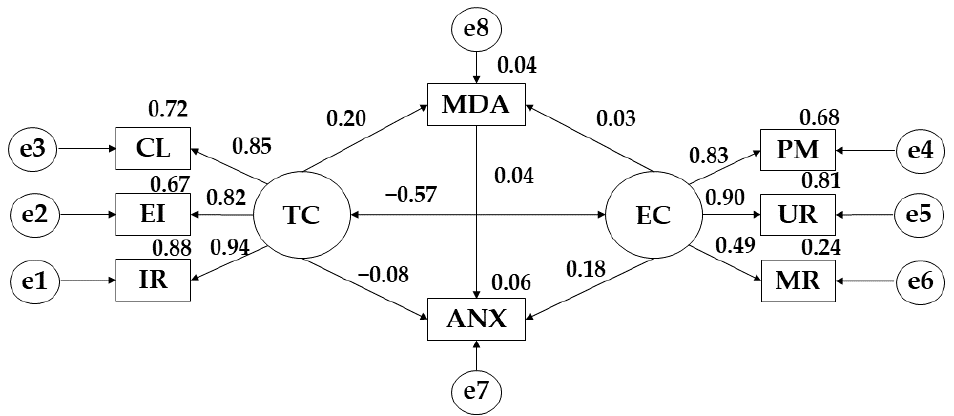
Figure 4. Theoretical model proposed for participants showing a high level of weekly PA. Note: EC = Ego climate; TC = Task climate; PM = Punishment for mistakes; UR = Unequal recognition; MR = Member rivalry; CL = Cooperative learning; EI = Effort/improvement; IR = Important role; ANX = Anxiety; MDA = Mediterranean diet adherence. Table 4. Structural model for participants showing a high level of weekly PA.